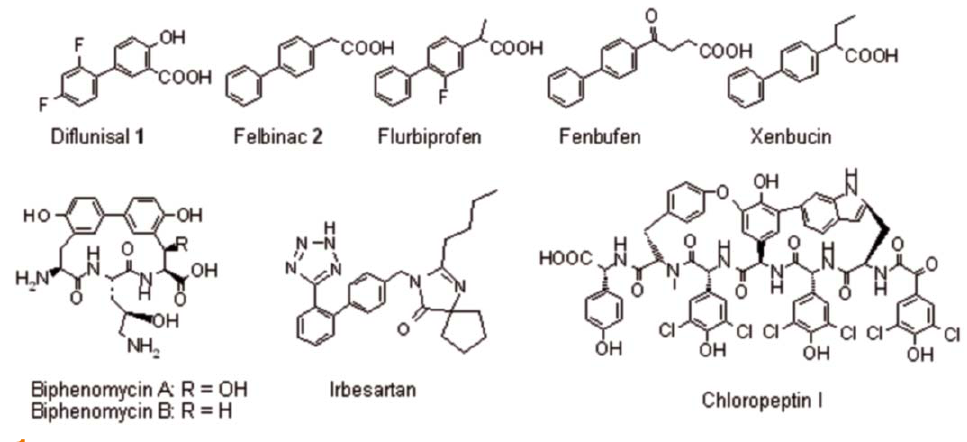
Figure 1. Examples of drugs containing a biaryl moiety.